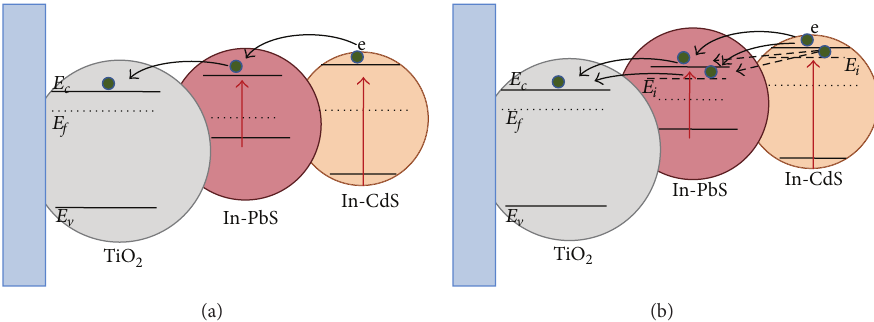
Figure 6: The schematic illustration of the carrier transfer in the (a) TiO 2 /PbS/CdS film and (b) TiO 2 /In-PbS/In-CdS film. Black arrow showed the electron transport; red arrow showed the electron